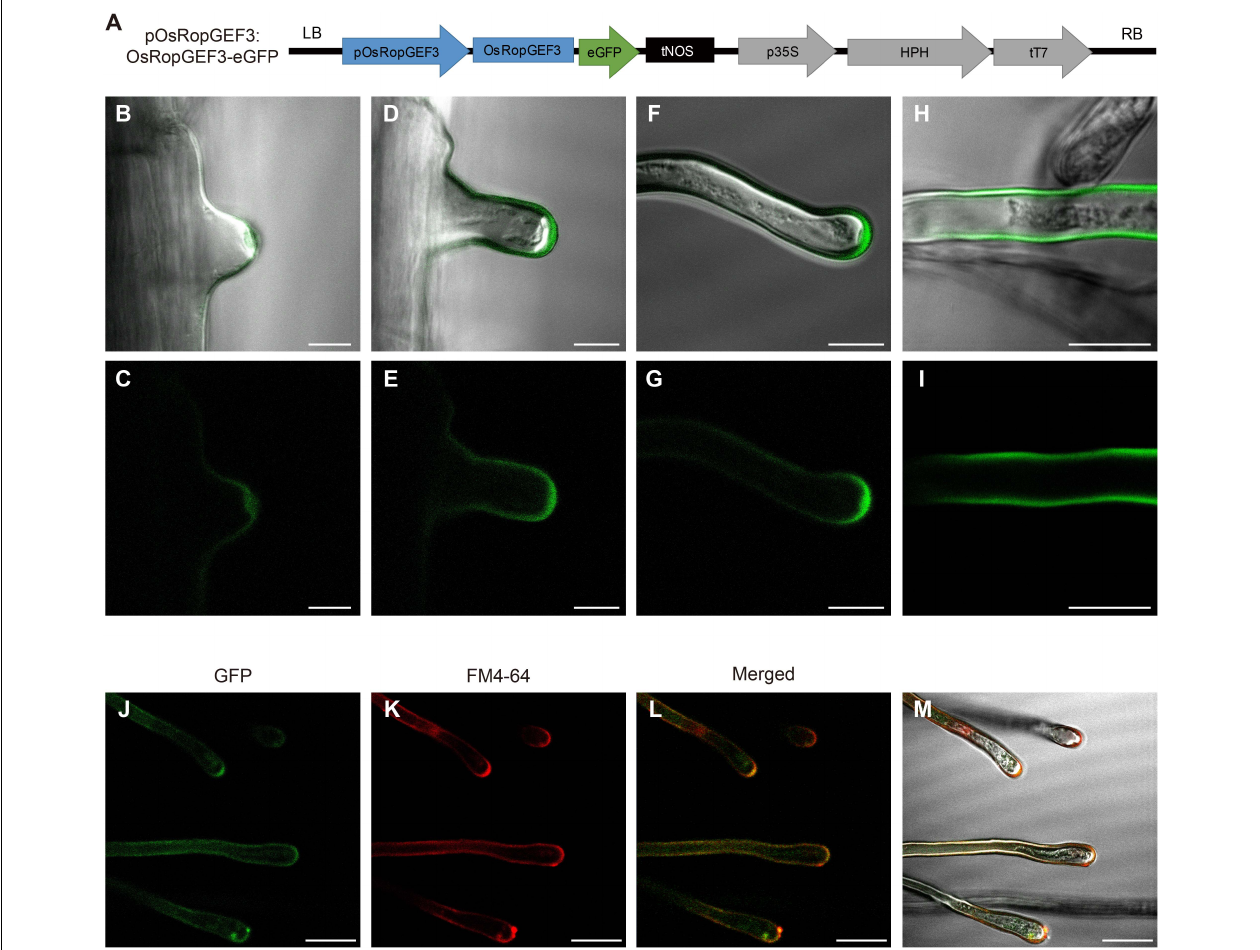
FIGURE 2 | Subcellular localization of OsRopGEF3 in the growing root hairs in rice. (A) The pGA3427 vector map used for gain-of-function and fluorescent tagging of OsRopGEF3 genes. OsRopGEF3 native promoter, 2,000 base pairs upstream from the start codon, allowed it to be overexpressed only on the root hairs and tagged with an eGFP (pOsRopGEF3:OsRopGEF3-eGFP). The pGA3427 vector contains a sequence of hygromycin-resistance genes. LB, left border of the vector; RB, right border of the vector; pOsRopGEF3, promoter sequence of OsRopGEF3 ; eGFP, enhance green fluorescence protein; tNOS, NOS terminator; p35S, 35S promoter; HPH, hygromycin-B-phosphotransferase gene; tT7, T7 terminator. (B–I) The confocal images of rice root hair in transgenic lines (pOsRopGEF3:OsRopGEF3-eGFP). As root hairs gradually grow, the subcellular localization of OsRopGEF3 protein was detected by fluorescence. (B,C) The apical tip part of the initiation states, (D–G) the apical tip part of the elongation states, (H,I) fully grown root hairs, and (J–M) representative confocal images of the root hair in transgenic line stained with FM4-64 dye. FM4-64 was checked on the RFP channel. Bars = 10 µ m (B–I) and 20 µ m (J–M) .